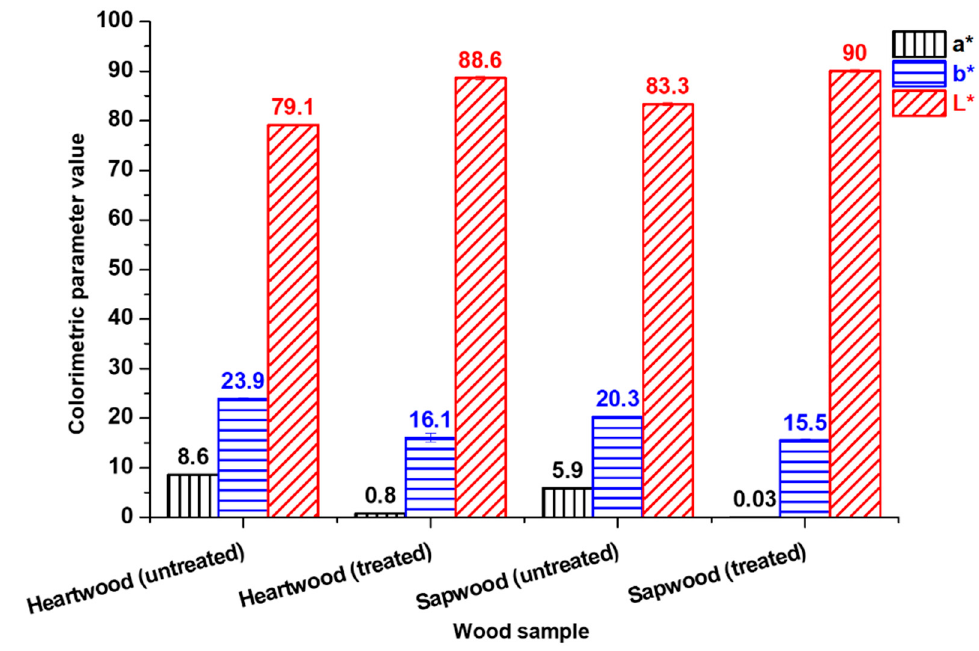
Figure 2. Influence of H 2 O 2 treatment on maritime pine heartwood and sapwood colorimetric parameters.